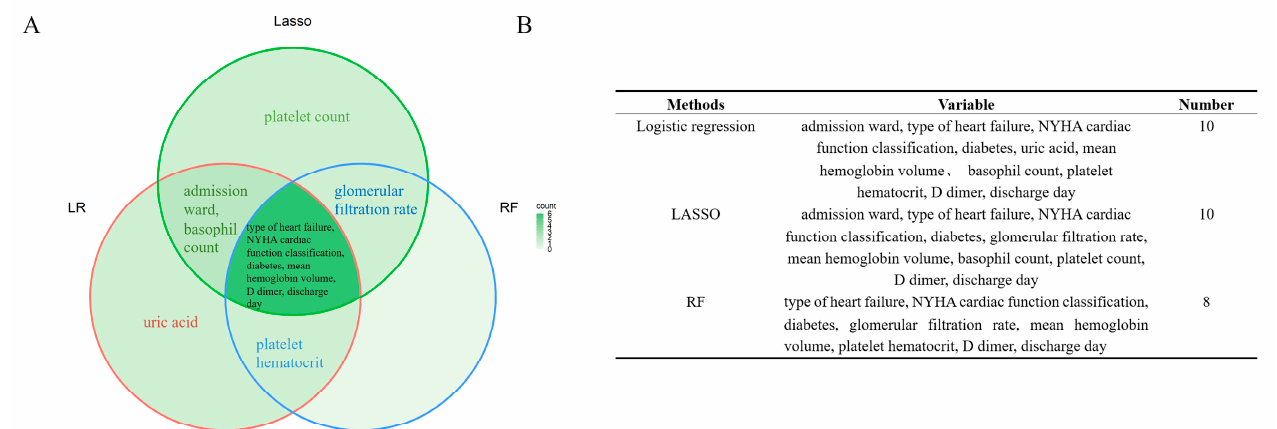
Figure 2. The results of three variable screening methods. RF = random forest; LR = logistic regression; LASSO = least absolute shrinkage and selection operator regression. ( A ): Venn presents the result of the variable selection. ( B ): A total of 10 variables were screened by logistic regression and LASSO regression, and eight variables were screened by random forest, six of which were common to the results of the three methods.